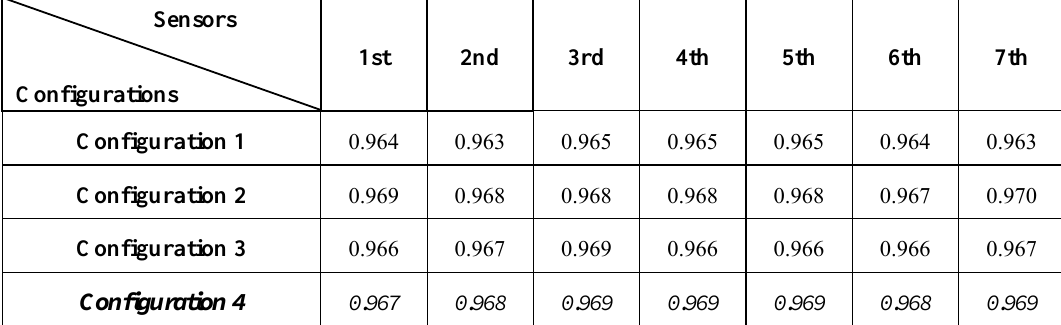
Table 1. PCI value for single fault (f = 7 σ , 3000 simulations, 30